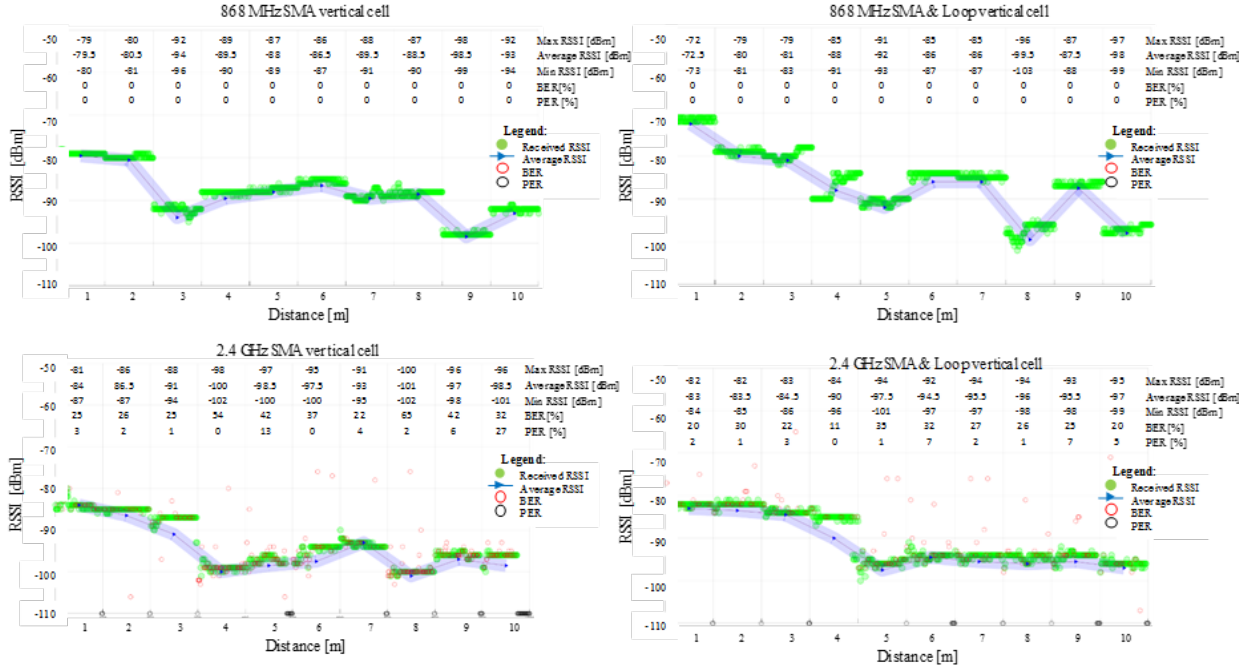
Figure 7. Experimental measurements received signal strength indicator (RSSI), bit error rate (BER) and packet error rate (PER) for 868 MHz and 2.4 GHz communication over the 1 m up to 10 m separation between the two RF transceivers. The radiative cell’s shell is in vertical orientation towards the ground plane.